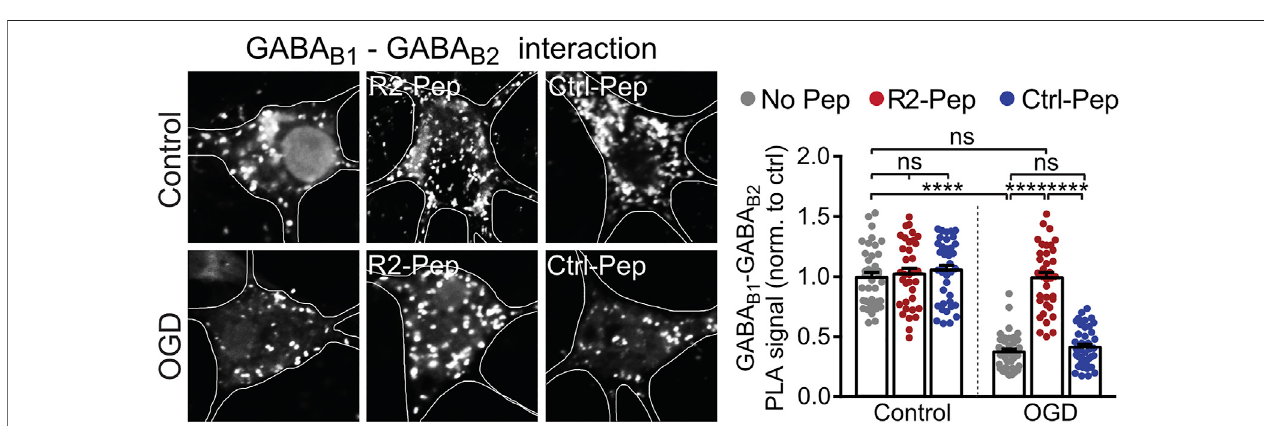
FIGURE 4 | CHOP-mediated decrease of GABA B receptor heterodimerization is rescued by R2-Pep. Cultures were stressed for 1 h with OGD and immediately thereafter treated with R2-Pep, the inactive Ctrl-Pep or remained untreated. After 3 h, the interaction between GABA B1 and GABA B2 was tested by in situ PLA. Left: representative images (scale bar: 5 μ m). Right: quanti fi cation of the GABA B1 -GABA B2 interaction in control or OGD treated neurons in the absence or presence of R2- Pep or Rand-Pep. The interaction level observed in untreated neurons served as control. The data represent the mean ± S.E.M. of 37 – 41 neurons for each experimental condition derived from three independent experiments. ****, p < 0.0001; ns: p > 0.05; two-way ANOVA with Tukey ’ s multiple comparisons test.